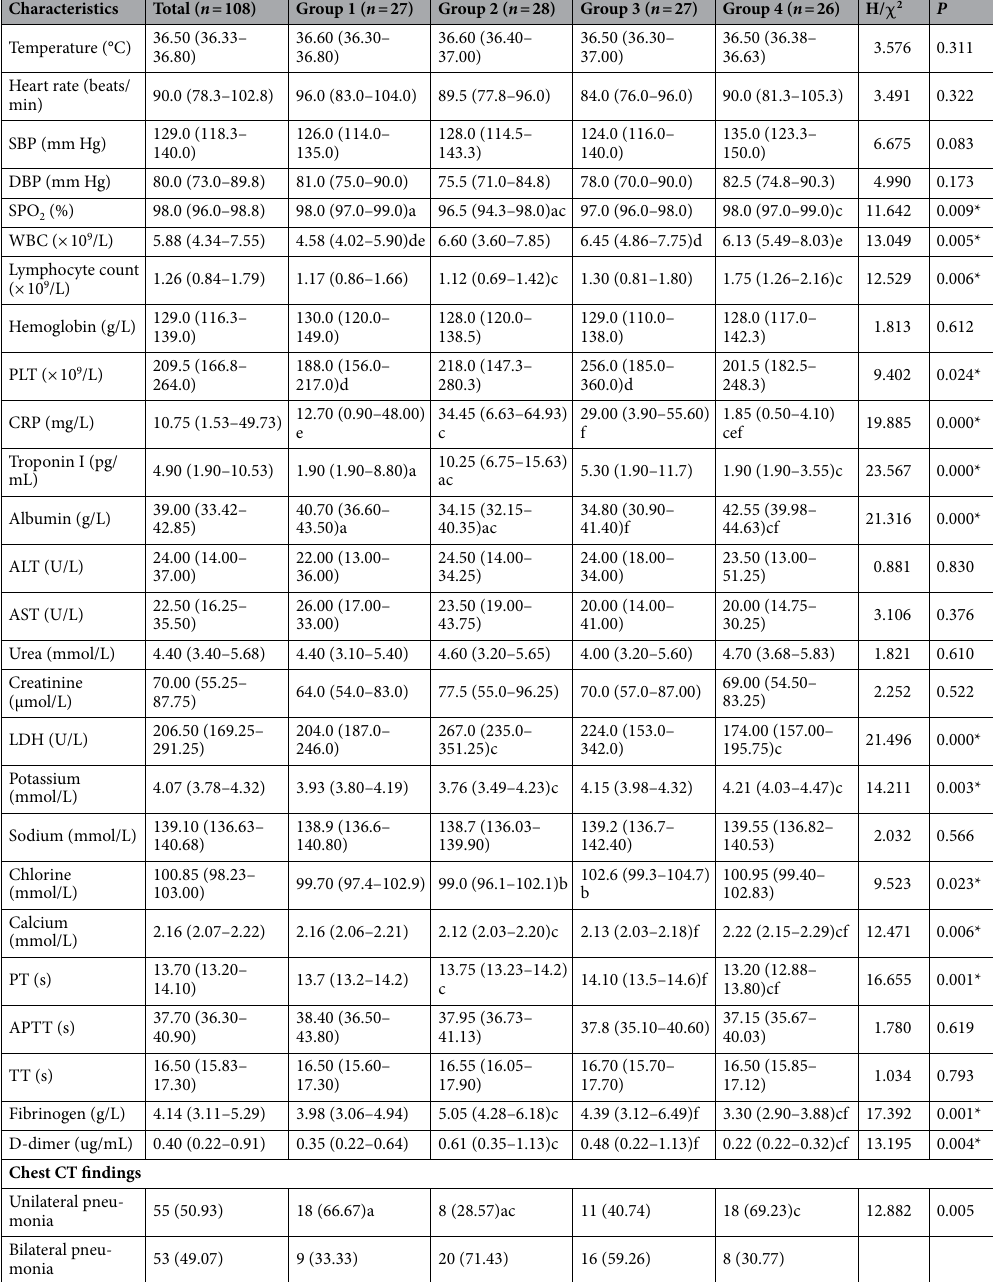
Table 2. Comparisons of vital signs, laboratory indices, and radiographic findings across the four groups. Data are shown as median (interquartile range) or n (%). SBP systolic blood pressure, DBP diastolic blood